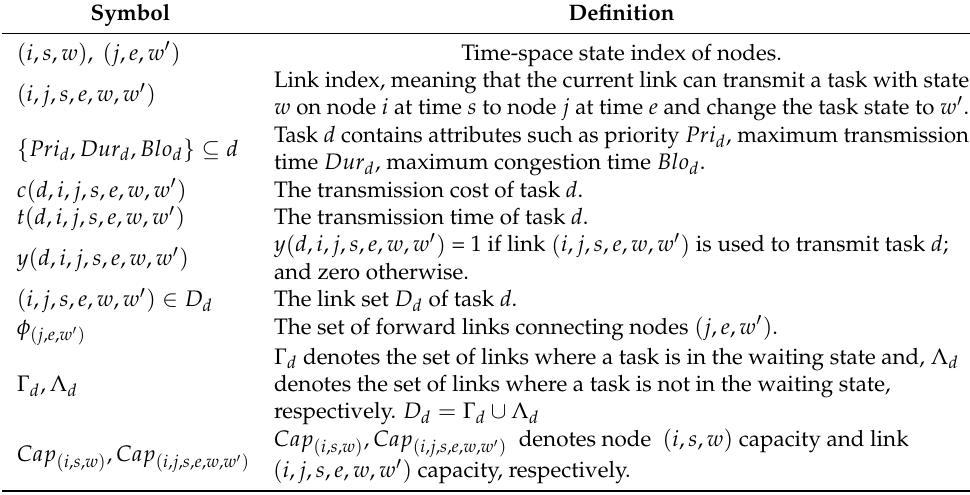
Table 3. Sets, indices, and